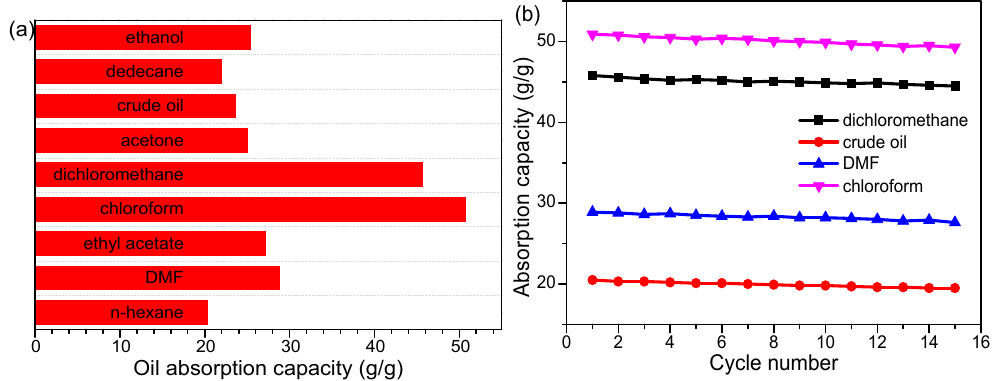
Figure 10. ( a ) Absorption capacity of the as-prepared cotton for different oils and ( b ) reusability of the as-prepared cotton in four different oils.